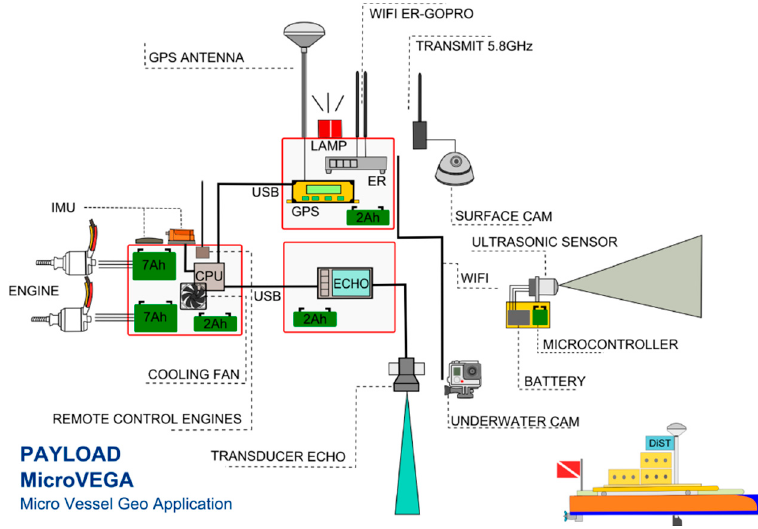
Figure 4. Payload of MicroVeGA drone.